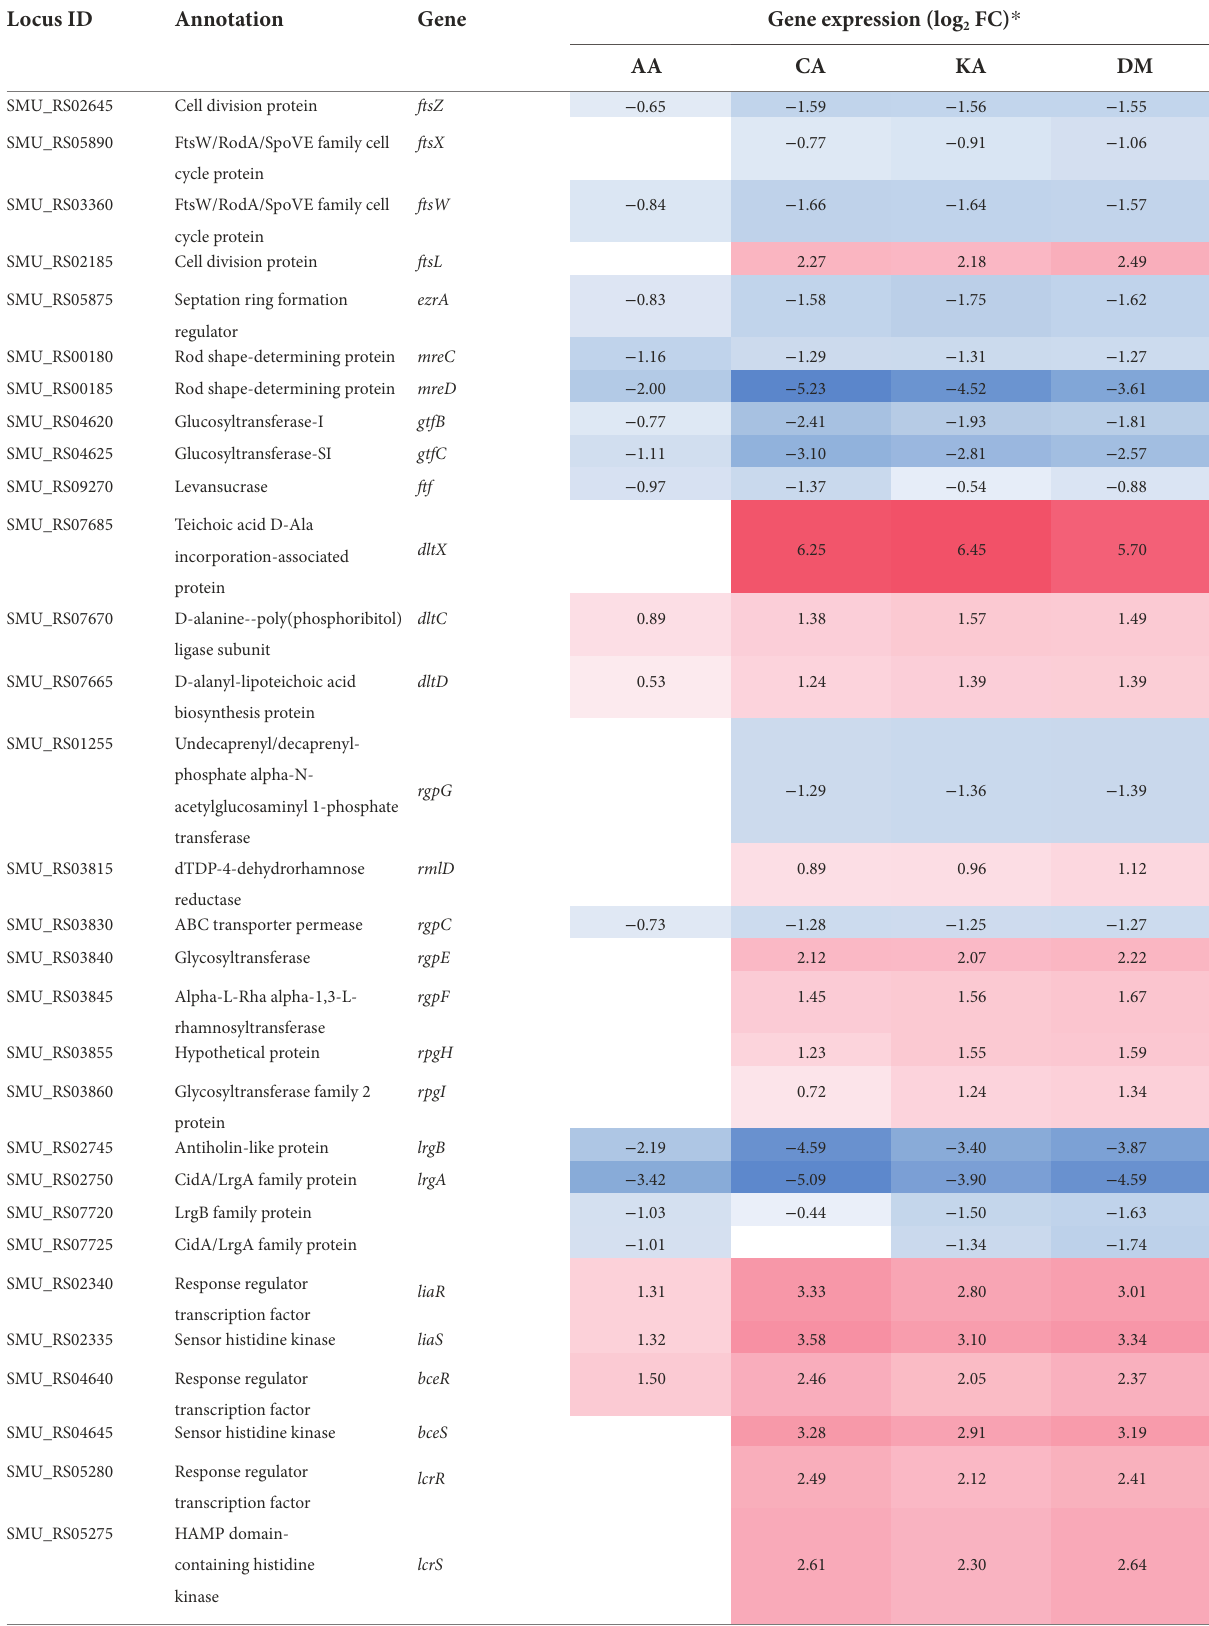
TABLE 3 Differential gene expression associated with cell division and cell envelope biogenesis. Locus ID